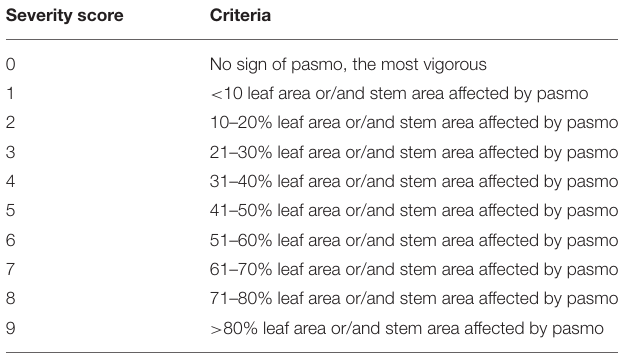
TABLE 1 | Criteria for field assessment of pasmo severity on a scale of